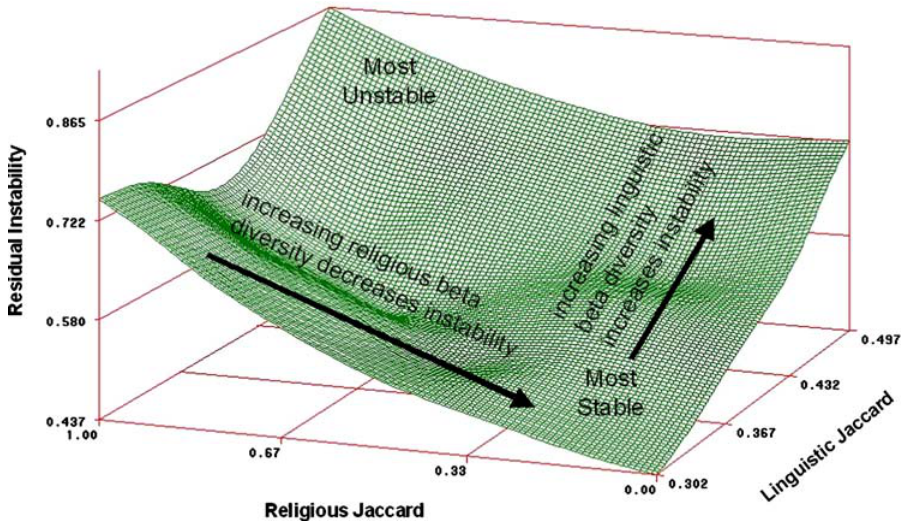
Figure 3. Visualization of interactive effects of linguistic b diversity and religious b diversity on societal instability.